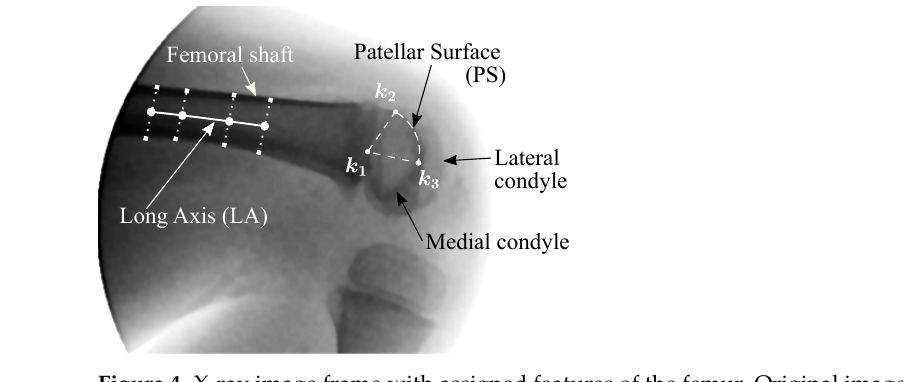
Figure 4. X-ray image frame with assigned features of the femur. Original image was adjusted for visualization purposes.